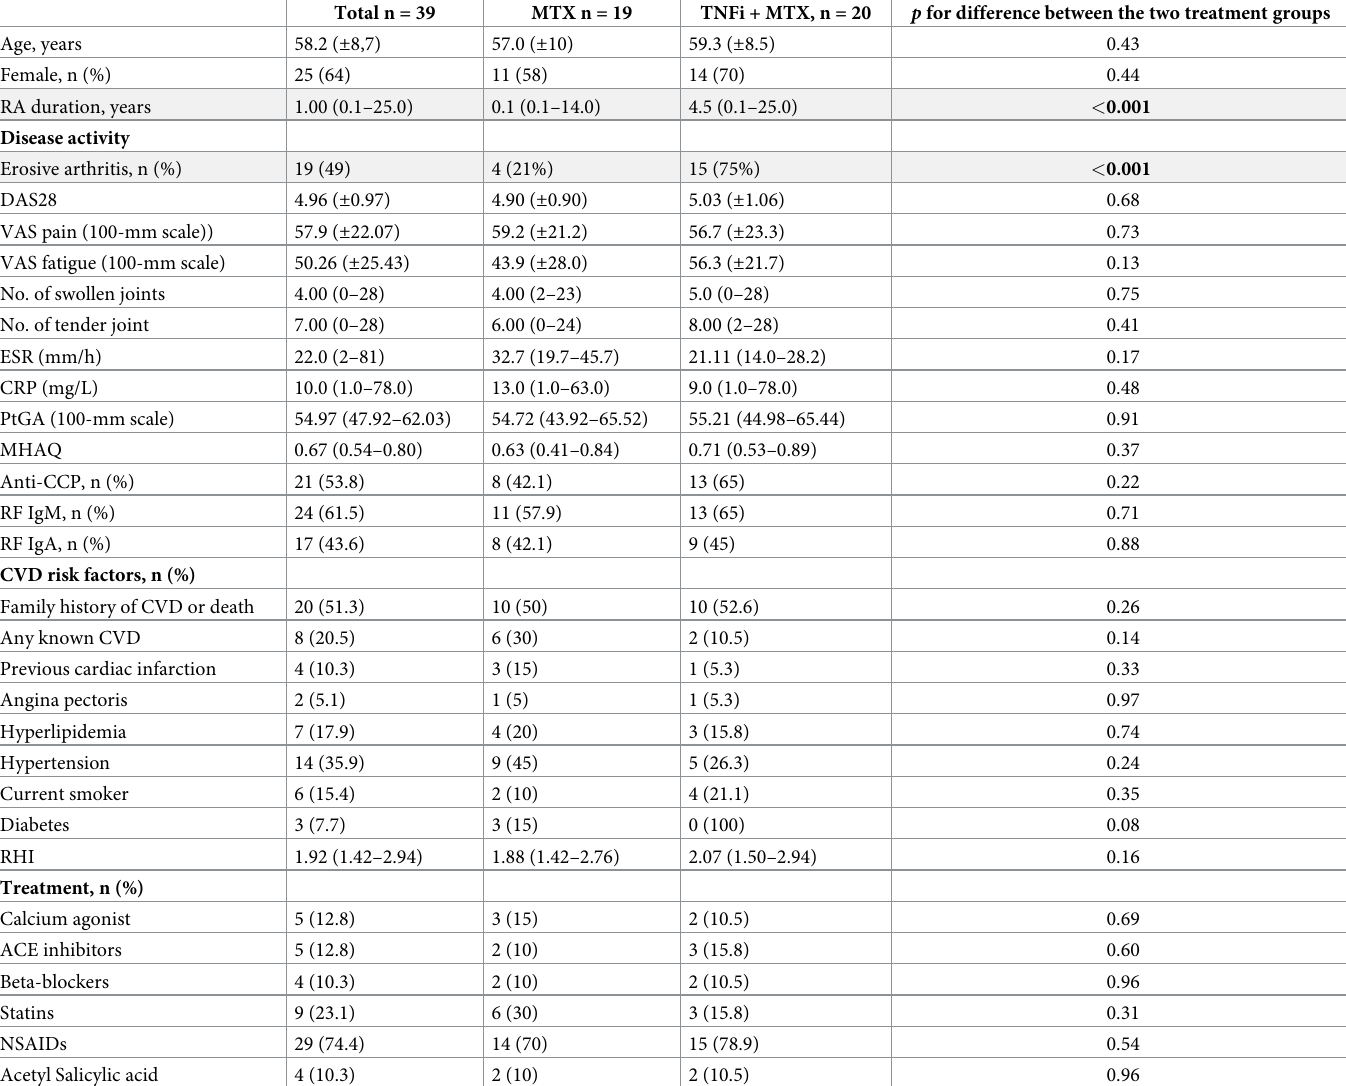
Table 1. Patient baseline characteristics.